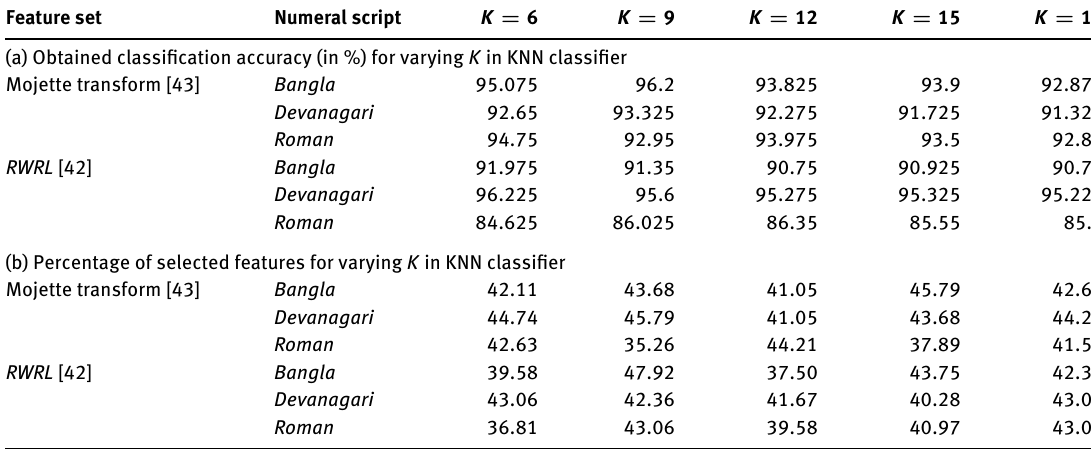
Table 4: Effect of Change in the Value of K in KNN Classifier with (a) Classification Accuracy of Selected Features and (b) Percentage of Features Selected in E1.